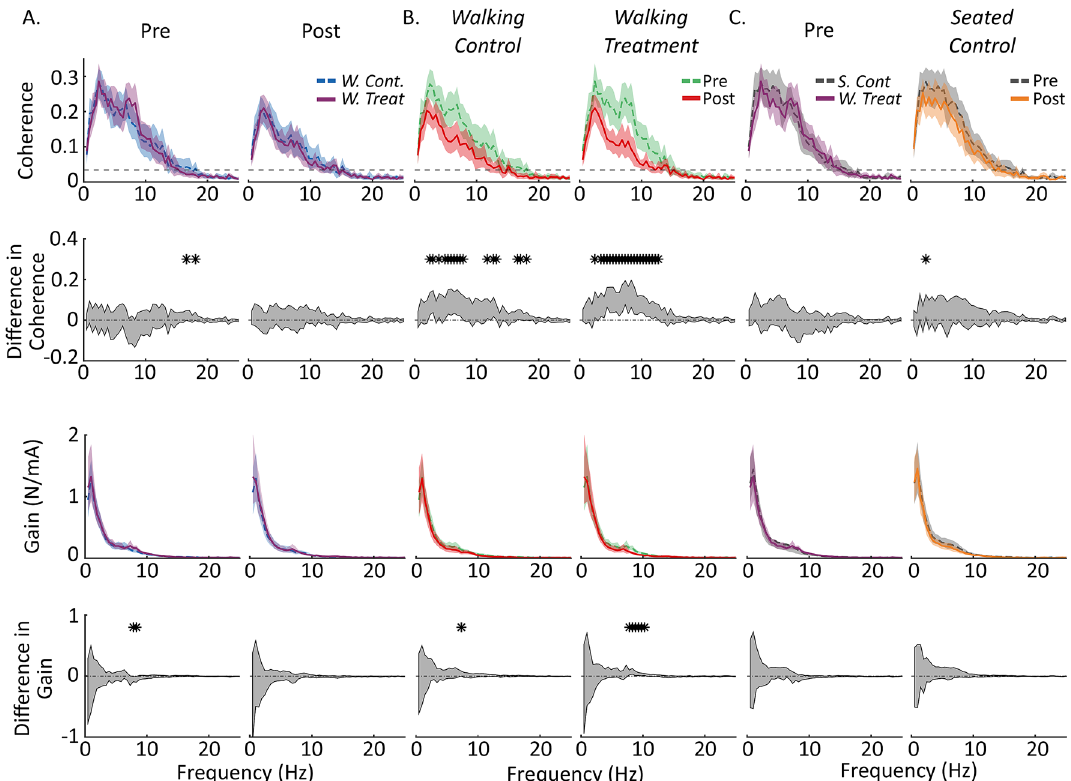
Figure 2. Coherence spectra and 95% confidence intervals for each of the standing conditions and their statistical comparisons. ( A ) Coherence and gain spectra for the pre and post-standing periods. The blue segmented line is the Walking Control condition, and the violet solid line is the Walking Treatment condition. Both before and after walking the coherence and gain spectra for the two conditions are not broadly statistically different. The segmented lines in the upper panels (coherence) are the 95% confidence limits. Coherence lower than these limits were not significantly different than zero. ( B ) Coherence and gain spectra compared pre and post within the Walking Control and Walking Treatment conditions. The green segmented lines are the pre- standing periods and the red solid lines are the post-standing periods. After walking, coherence decreased regardless of whether participants received stimulation. Gain did not exhibit any broad differences between pre and post. ( C ) The first column is the pre-standing period for the Seated Control (gray segmented line) compared to the pre-standing period for the Walking Treatment condition (violet solid line). There were no broad significant differences between the two groups at the start. The second column in ( C ) compares the pre and post-standing periods for the Seated Control condition. No broad significant differences existed between the two standing periods in the Seated Control condition. Each curve n = 15, and the difference in coherence and gain (row 2 and row 4) was evaluated by bootstrapping the difference in means between the two coherence distributions and determining the 95% confidence interval for the difference in mean distribution (gray segmented line surrounding the shaded region). Regions where the 95% confidence interval for the difference in means excluded zero were deemed significantly different and have been indicated with a